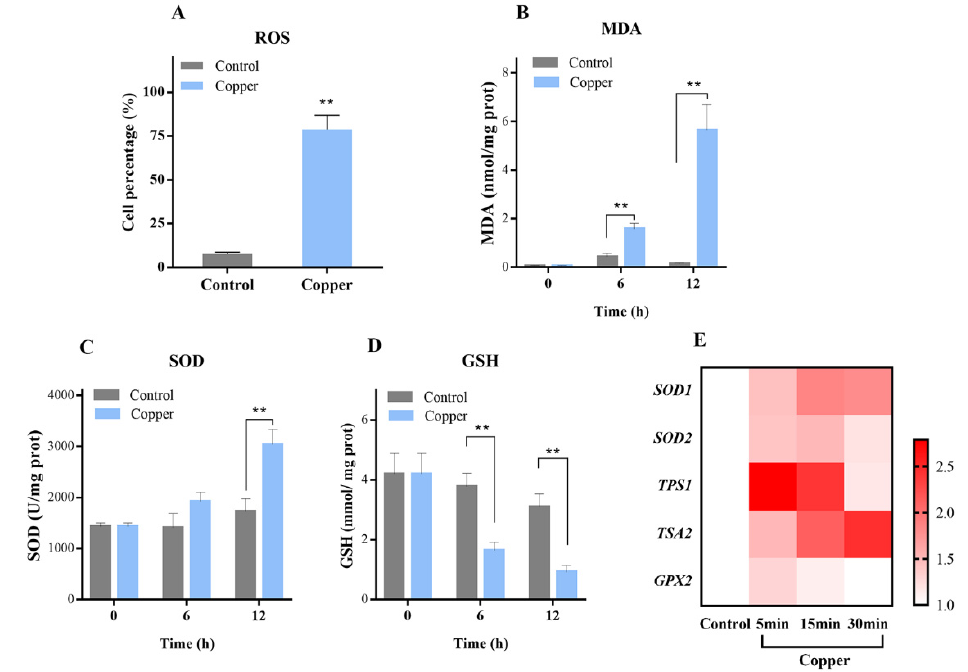
Figure 1. The distinct oxidative stresses induced by copper: ( A ) the effect of copper on ROS levels in S. cerevisiae ; ( B ) the effect of copper on MDA levels in S. cerevisiae ; ( C ) the effect of copper on SOD activity in S. cerevisiae ; ( D ) the effect of copper on GSH content in S. cerevisiae ; and ( E ) the transcription levels of genes involved in the oxidative stress response. ** p < 0.01.